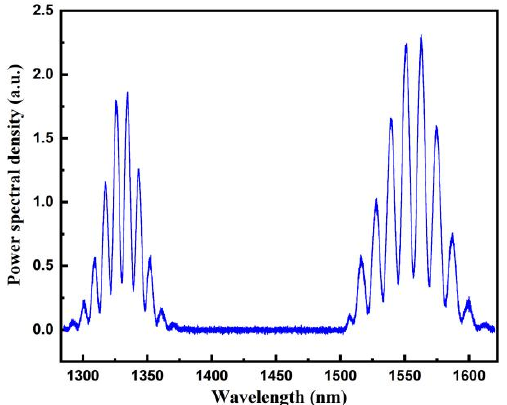
Figure 10. Reflection spectrum of a 100.214 µ m fiber-optic F–P sensor.